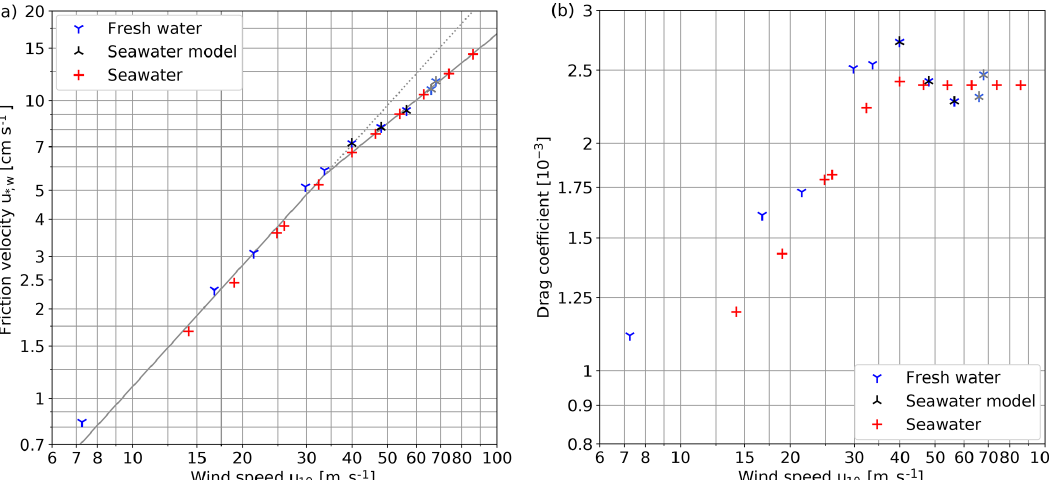
Figure 4. Relationship between the wind speed at 10m height, u 10 , and the water-side friction velocity (a) and the drag coefficient calculated using Eq. (16) (b) . Lighter colors mark conditions where the friction velocity was approximated; see Sect.